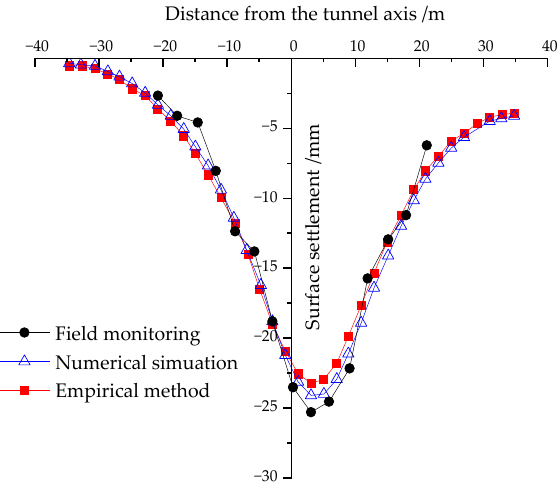
Figure 5. Surface settlement obtained from different methods.